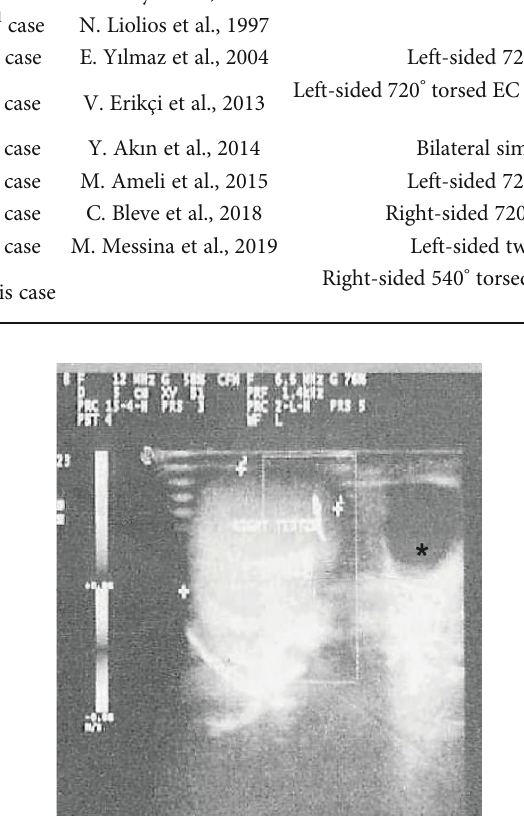
Figure 1: Ultrasound image of right testis with epididymal cyst ∗ (on acute presentation).